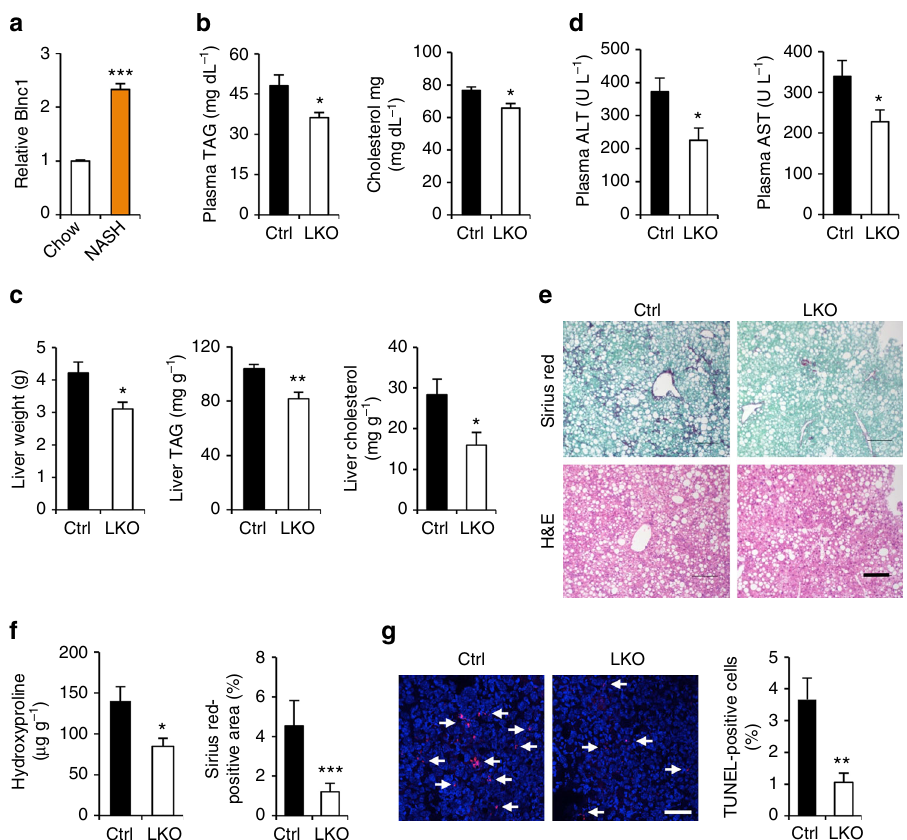
Fig. 6 Blnc1 inactivation ameliorates diet-induced NASH. a Blnc1 expression in mice fed chow ( n = 3) or NASH ( n = 3) diet for 6 months. Data represent mean ± SEM. *** p < 0.001, chow vs. NASH, two-tailed unpaired Student ’ s t -test. ( b – d ) Plasma lipids ( b ), liver weight, TAG and cholesterol content ( c ) and plasma ALT and AST levels ( d ) in ctrl ( fi lled, n = 6) and LKO (open, n = 6) mice fed NASH diet for 24 weeks. e H&E and Sirius red staining of liver sections. Scare bar = 100 μ m. f Liver hydroxyproline content and quantitation of Sirius red-positive area in e . g TUNEL staining and quantitation (scale bar = 100 μ m). Data in ( b – d ), ( f ) and ( g ) represent mean ± SEM. * p < 0.05, ** p < 0.01, *** p < 0.001. Ctrl vs. LKO, two-tailed unpaired Student ’ s t